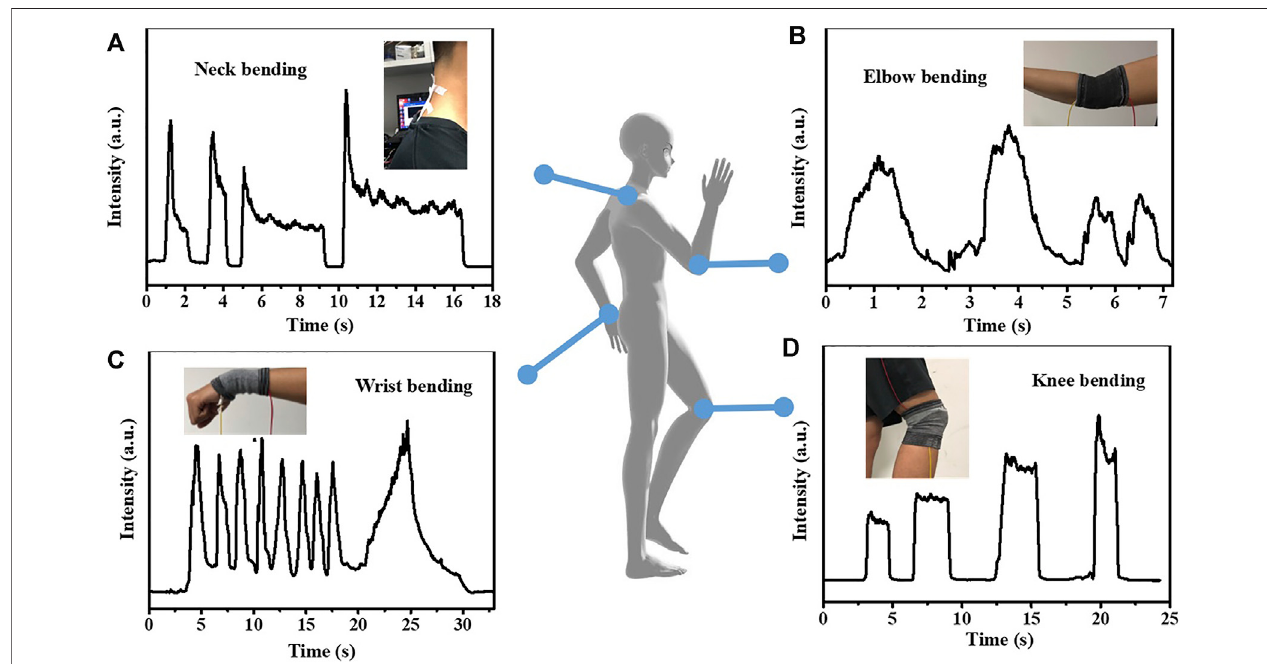
FIGURE 8 | Applications of the fl exible graphene strain sensor for detecting various large human motions. Corresponding electrical response to (A) neck bending, (B) elbow bending, (C) wrist bending, and (D) knee bending.